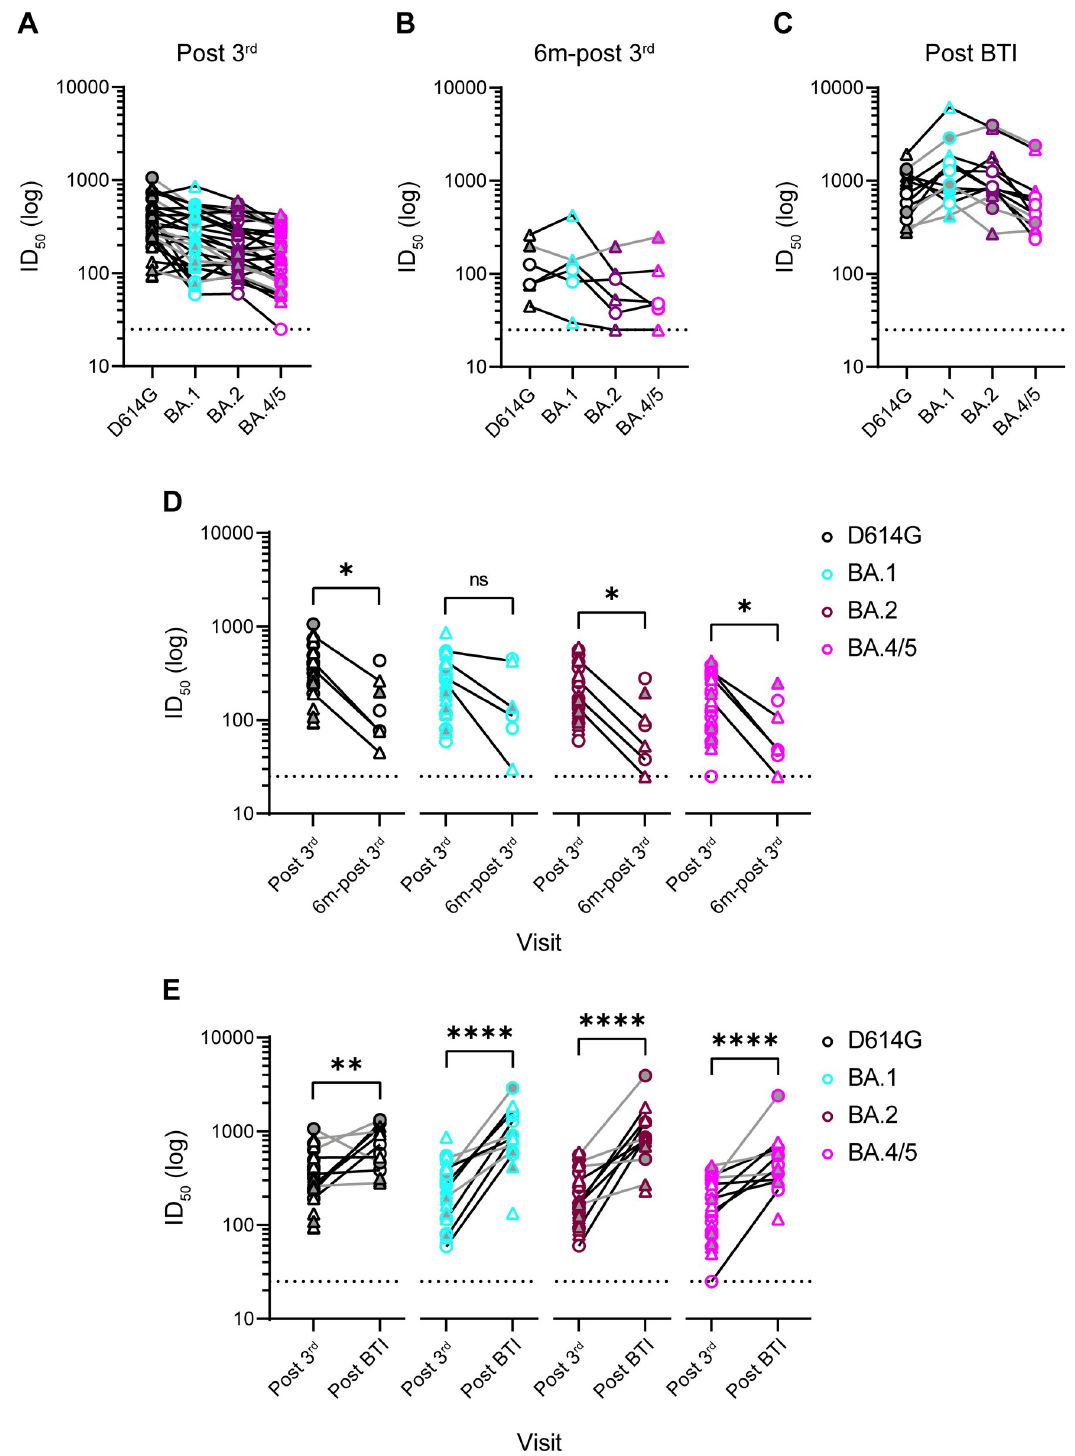
Fig 7. Neutralization against omicron sub-lineages following 3 vaccine doses and/or BA.1/BA.2 breakthrough infection. Neutralization breadth and potency was measured against D614G, BA.1, BA.2 and BA.4/BA.5. Analysis of sera collected A) 3-weeks post 3 rd BNT162b2 vaccine dose (post 3 rd ), B) 6-months post 3 rd vaccine (6m-post 3 rd ) and C) following breakthrough infection (post-BTI) (presumed to be BA.1 or BA.2). D) Comparison of titres 3-weeks (post 3 rd ) and 6-months post 3 rd boost (6m-post 3 rd ). E) Comparison of titres 3-weeks post 3 rd boost (post 3 rd ) and following BTI (post-BTI). Samples from a single individual are joined.